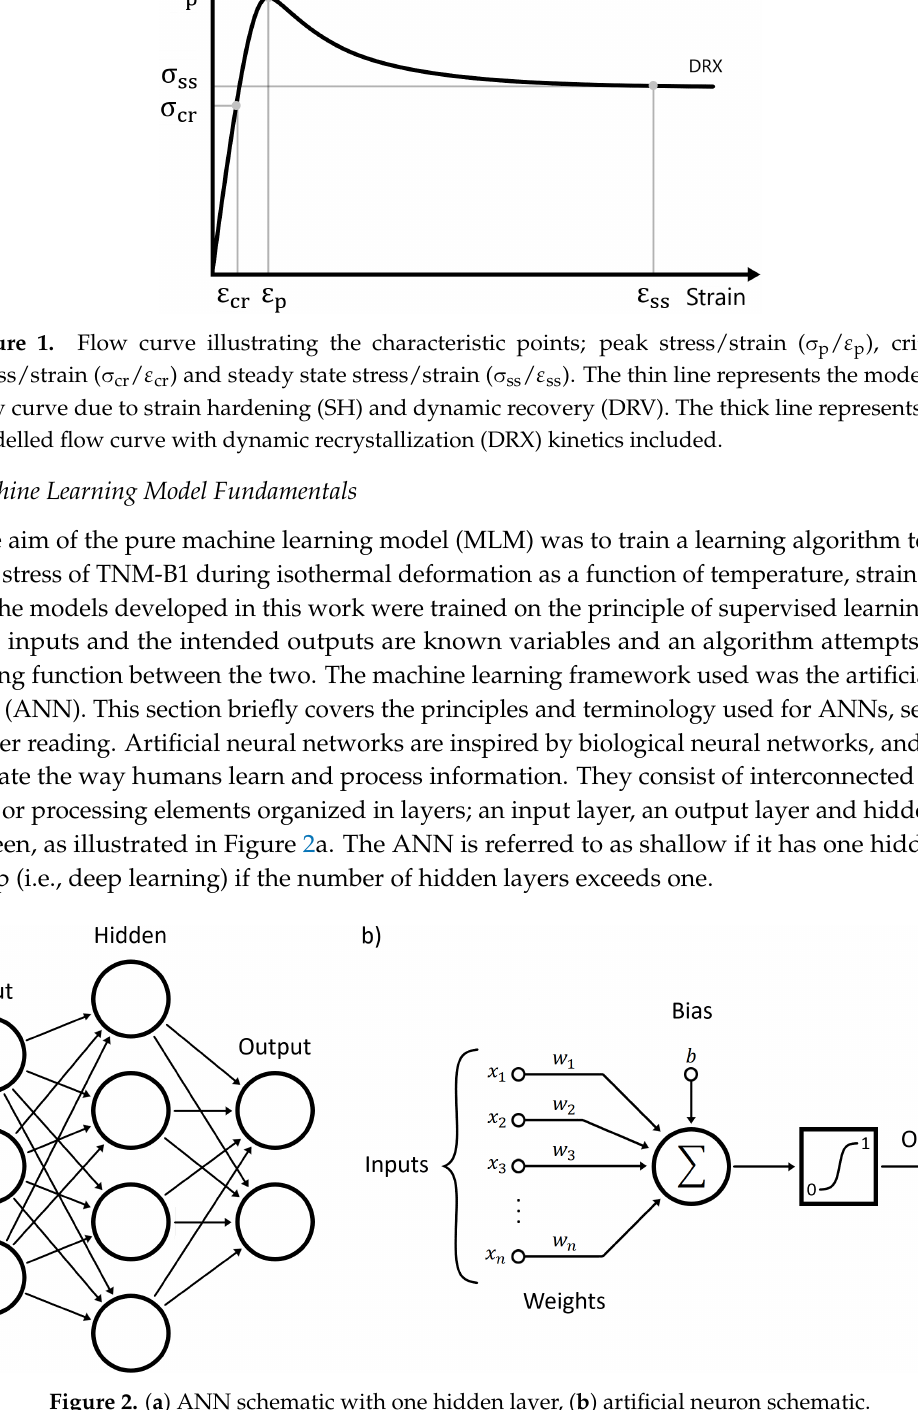
Figure 2. ( a ) ANN schematic with one hidden layer, ( b ) artificial neuron